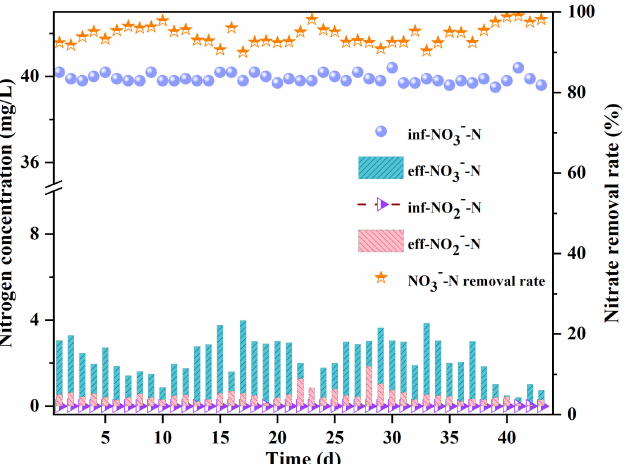
Figure 6. Denitrification performance of SHD − EHD under optimal conditions (I = 40 mA, HRT = 4 h, pH = 7.4~7.5, inf-NO − -N = 40 3